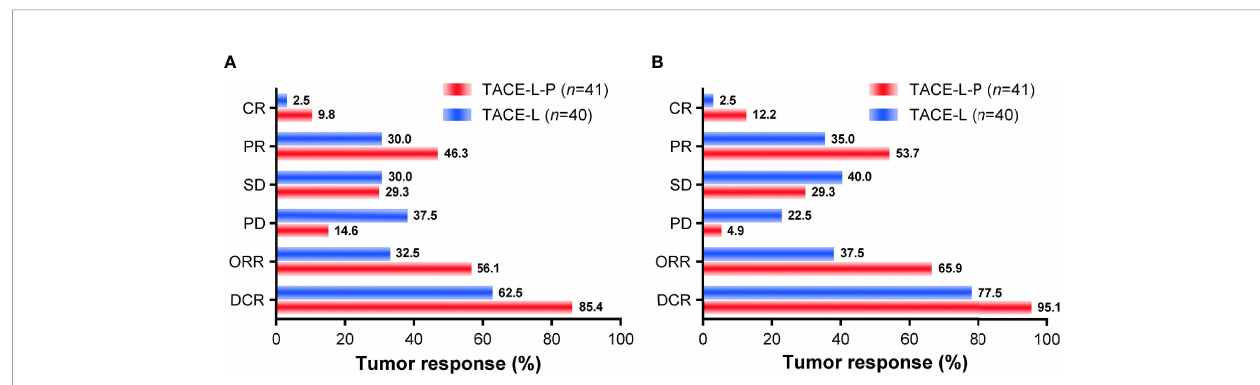
FIGURE 4 | Treatment responses of overall tumor (A) and intrahepatic tumor (B) for the two groups. TACE-L-P, transarterial chemoembolization combined with lenvatinib plus PD-1 inhibitor; TACE-L, transarterial chemoembolization combined with lenvatinib; CR, complete response; PR, partial response; SD, stable disease; PD, progressive disease; ORR, objective response rate; DCR, disease control